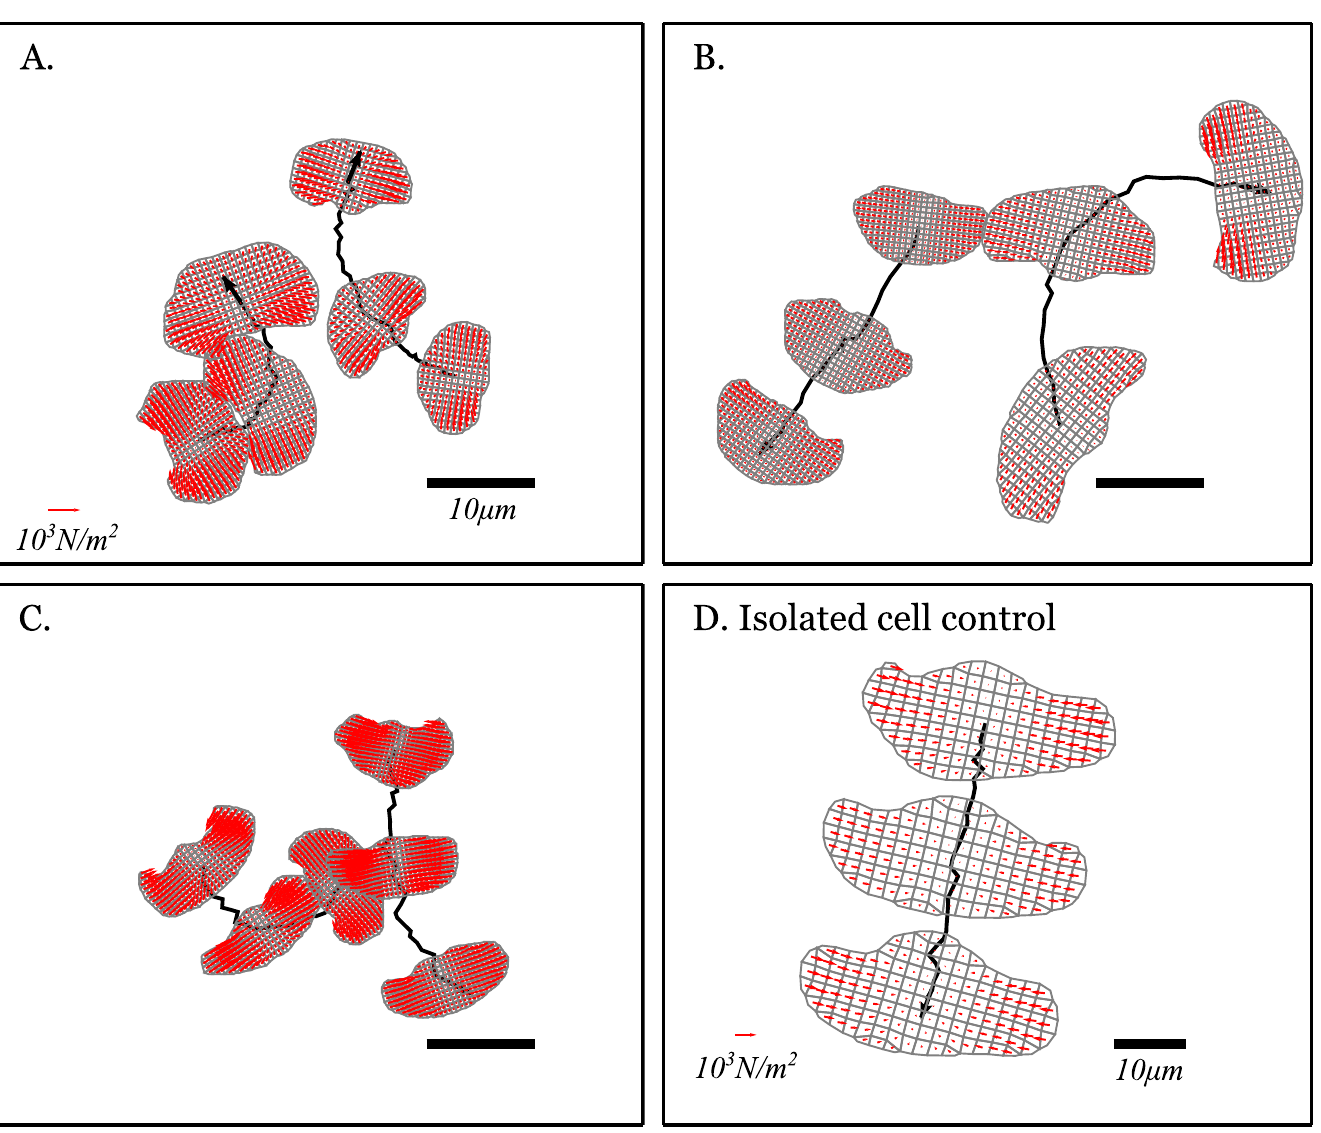
Fig 2. Trajectories of migrating keratocytes with their underlying traction map. Parts A-C: Cell turning induced by substrate mediated cell-cell interactions. Part D: An isolated cell moving from the top to the bottom of the observation region. In all panels, the cell contours and the traction force that both cells apply on the substrate (Red arrows) are shown. Within the same panel, the arrow length is indicative of the local traction force magnitude. The traction force was calculated from the analysis of substrate embedded bead displacements and linear elasticity theory [15, 18]. The traction is constrained to vanish outside the area covered by the cells and is calculated using an irregular mesh (shown in Gray). Note that the scale differs from Part D compared to the other panels, which are on the same scale. A red arrow in the bottom left of panels A and D indicate a traction equal to 10 3 N / m 2 and a black bar in the bottom right indicates a length equal to 10 μm . The final position of the cells is overlayed with an arrowhead and the total duration of the trajectories are 500, 250, 310 and 310 seconds in parts A, B, C and D, respectively. The traction maps for cell pairs undergoing collision avoidance represent 3 of 6 cells. The isolated cell is one of 3 whose tractions were mapped. Accompanying movies for the four panels are given in S1, S2, S3 and S4